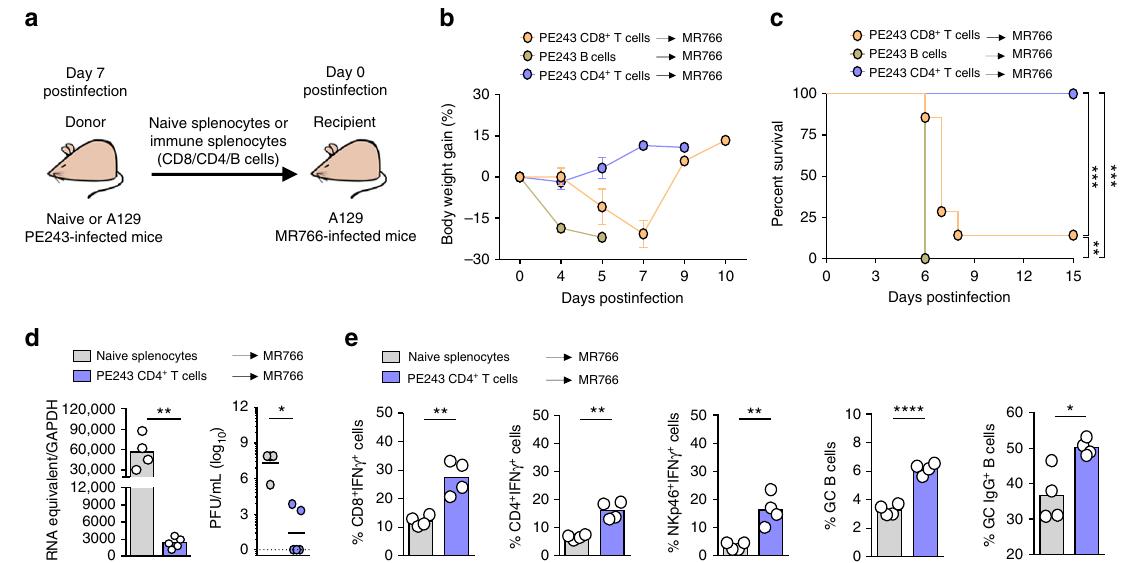
Fig. 4 CD4 + T cell plays an essential role in the resistance against ZIKV MR766 infection. Recipient A129 mice were inoculated intravenously with 2 × 10 5 PFU of lethal ZIKV strain MR766 simultaneously to the receipt of CD8 + T cells, B cells or CD4 + T cells obtained from ZIKV strain PE243-infected A129 donor mice at 7 days postinfection. Uninfected mice were used as donor of naive splenocytes. a Schematic representation of adoptive transfer protocol. b Body weight gain and c lethality of recipient A129 mice that received PE243-immune CD8 + T cells (1 × 10 7 /mouse) ( n = 7), CD4 + T cells (4 – 5 × 10 7 /mouse) ( n = 9) or B cells (1 × 10 7 /mouse) ( n = 4), monitored for up to 15 days postinfection. d ZIKV RNA copies and presence of ZIKV infectious particles in the brain of recipient mice that receive PE243-immune CD4 + T cells ( n = 5) or naive splenocytes ( n = 4) at 5 days